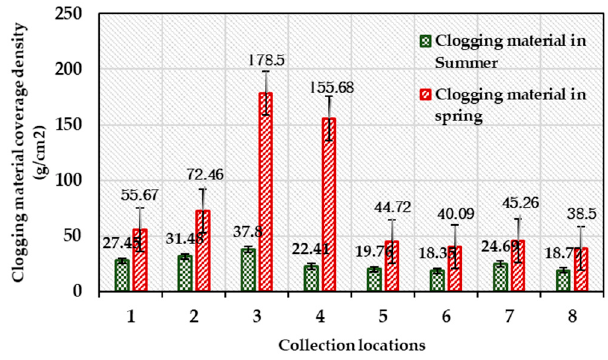
Figure 6. Clogging materials’ coverage density at different collection locations.